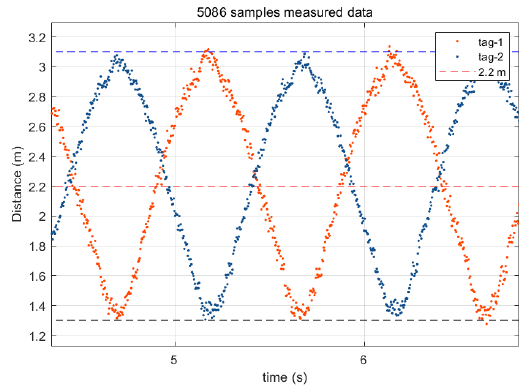
Figure 5. The ranging results of anchor by the Electro-rotating actuator (a detail view of 5 to 6